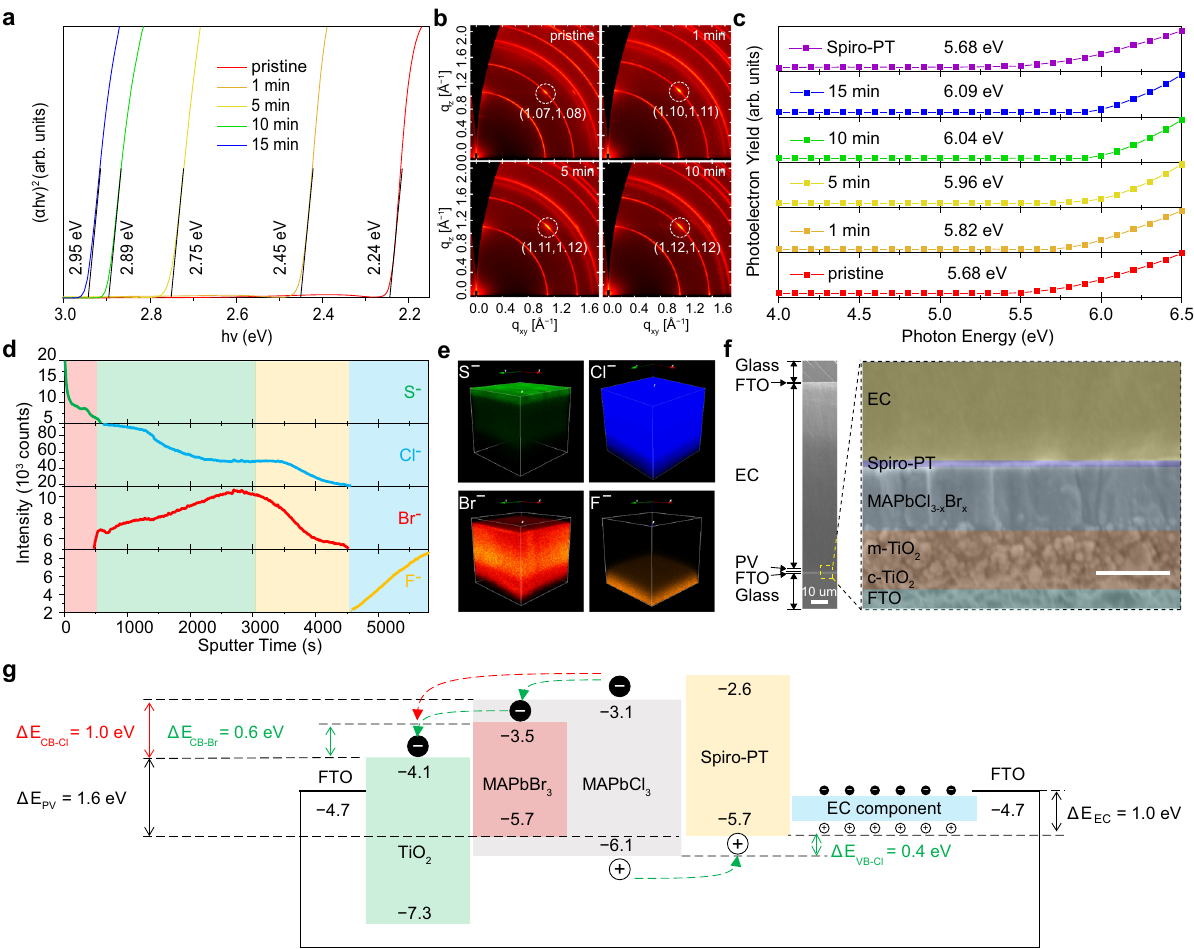
Fig. 2 Characterization analysis of PV components from semi-transparent to full-transparent and work mechanisms of monolithic PVCD. a Tauc plots of perovskites treated with halide diffusion periods of 0 min, 1 min, 5 min, 10 min and 15 min, respectively. b 2D-GIWAXS patterns of pristine MAPbBr 3 and MAPbBr x Cl 3 − x perovskites with a halide-exchanging period for 1, 5, and 10 min. c Valence band levels of Spiro-PT and MAPbBr x Cl 3 − x treated with different halide-diffusion periods. The VB values were determined by PYS. d ToF-SIMS depth pro fi les showed the concentration of selected species across the PV semi-module based on halide-exchanged MAPbBr x Cl 3 − x perovskite (10 min). e Reconstructed elemental 3D maps of negative ions traced in the depth pro fi le. The xy dimensions of the analyzed area of the fi lms were 80 μ m × 80 μ m. f Cross-section SEM images of a monolithic PVCD as glass/FTO/PV/ EC/FTO/glass device structure, with the detailed architecture of PV semi-module as c-TiO 2 /m-TiO 2 /MAPbBr x Cl 3 − x /Spiro-PT. Scale bar is 500 nm. g Schematic energy levels of monolithic PVCD, in which Br-rich perovskite in halide-diffused perovskites is one key factor. It can suppress the non-radiative recombination of large Δ E LUMO and improve electron extraction from perovskite to TiO 2 due to its intermediate LUMO level between Δ E 1 and Δ E 2